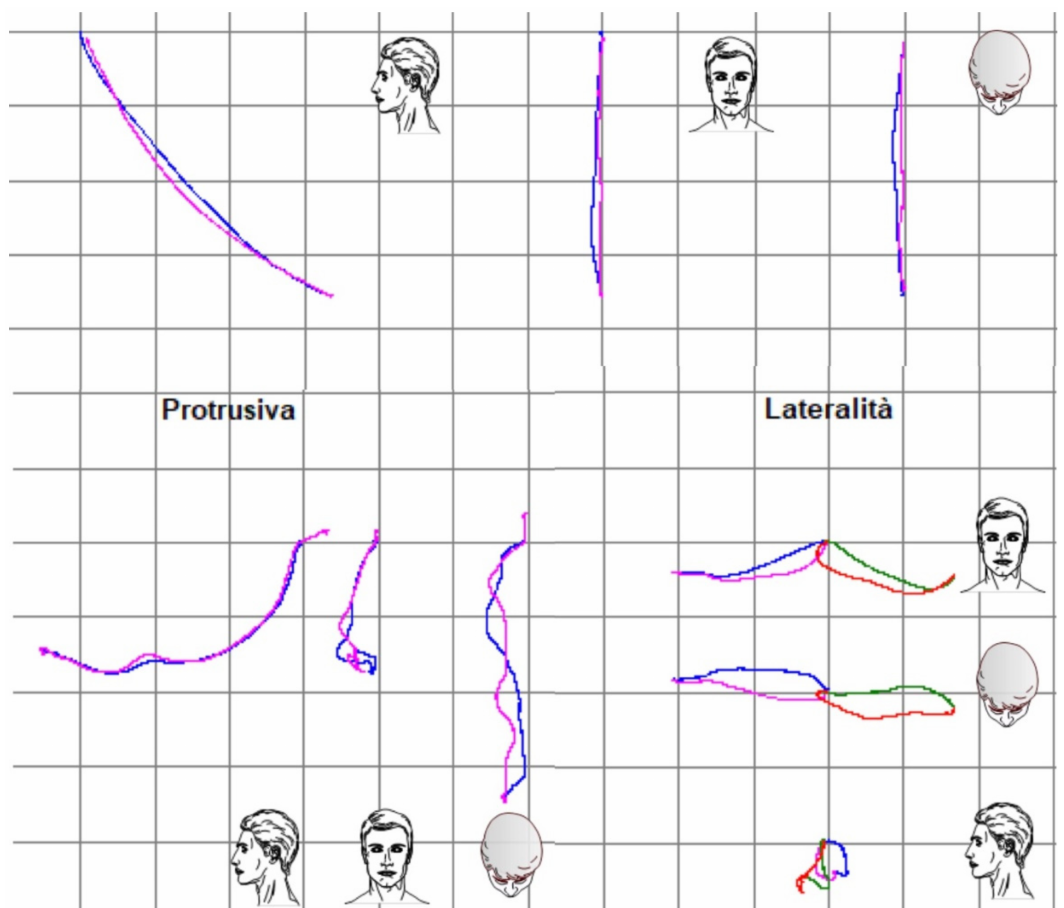
Figure 39. Comparison of kinesiograpic analysis before and after